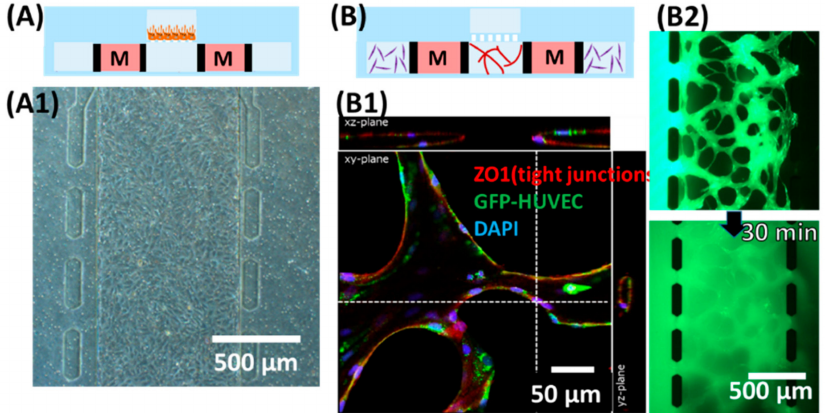
Figure 2. Demonstration of individual culturing chambers. ( A ) Culturing the human retinal pigmental epithelial cell (ARPE-19) monolayer in the upper channel. ( A1 ) Microscopic view focusing on the upper channel, showing monolayer of ARPE. ( B ) Formation of microvascular lumens in the lower channels. “M” (medium channels) corresponded to * (lower channel) in Figure 1A. ( B1 ) Confocal microscopic image staining for zonula occludens-1 (ZO1) and 4 (cid:48) ,6-diamidino-2-phenylindole (DAPI). ( B2 ) Snapshots taken after loading 70 kDa of FITC-dextran into one side of the lower channel immediately ( top ) and 30 min after ( bottom ).